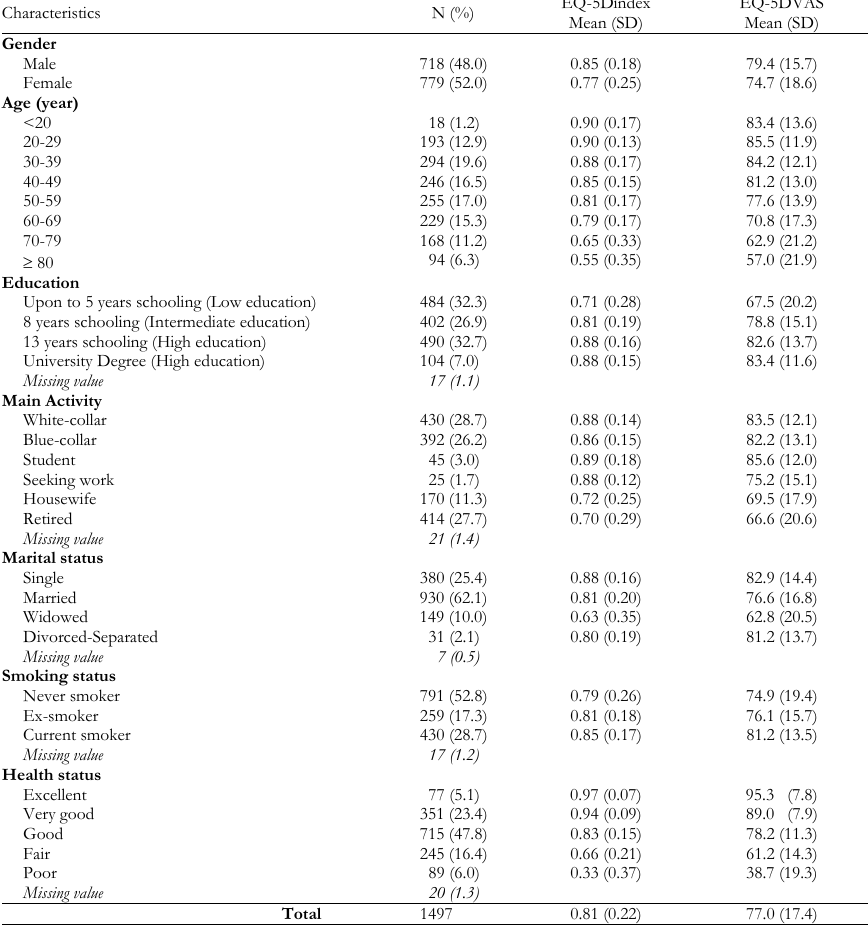
Socio-demographic characteristics of the sample and EQ-5D index mean and standard